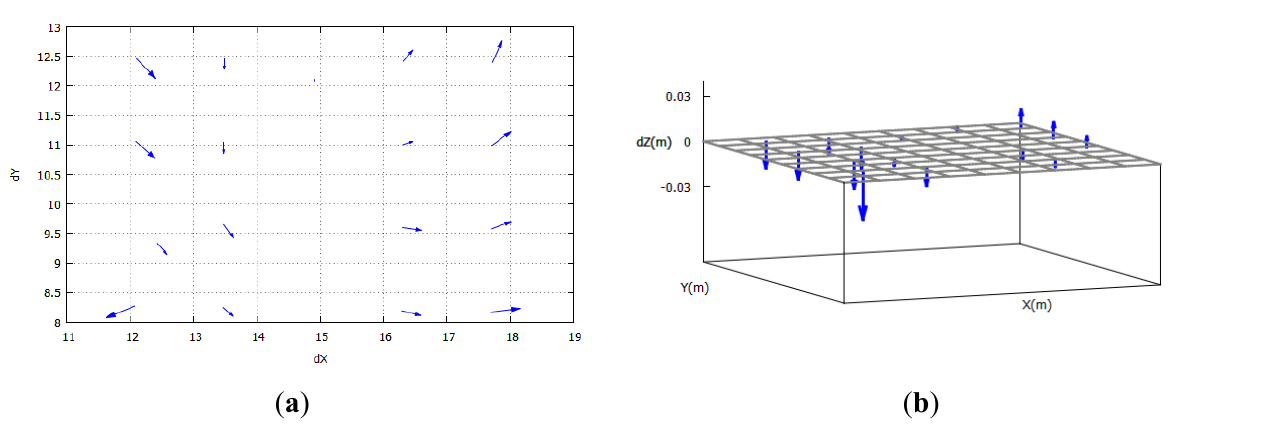
Figure 7. Needle map for ( a ) XY and ( b ) Z coordinates produced from the discrepancies between the estimated coordinates and their 17 tie